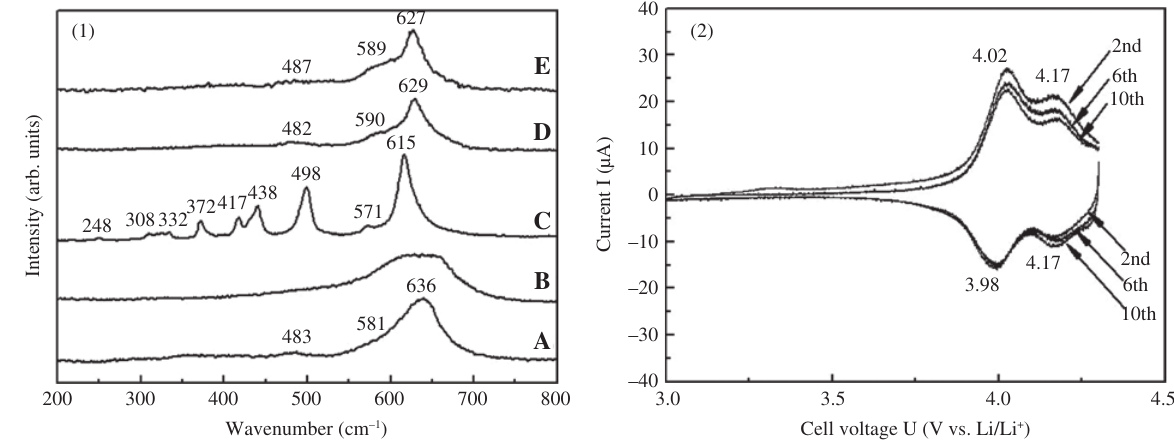
Mn O 0.88 1.98 4 Mn O , laser annealed for 0.88 1.98 4